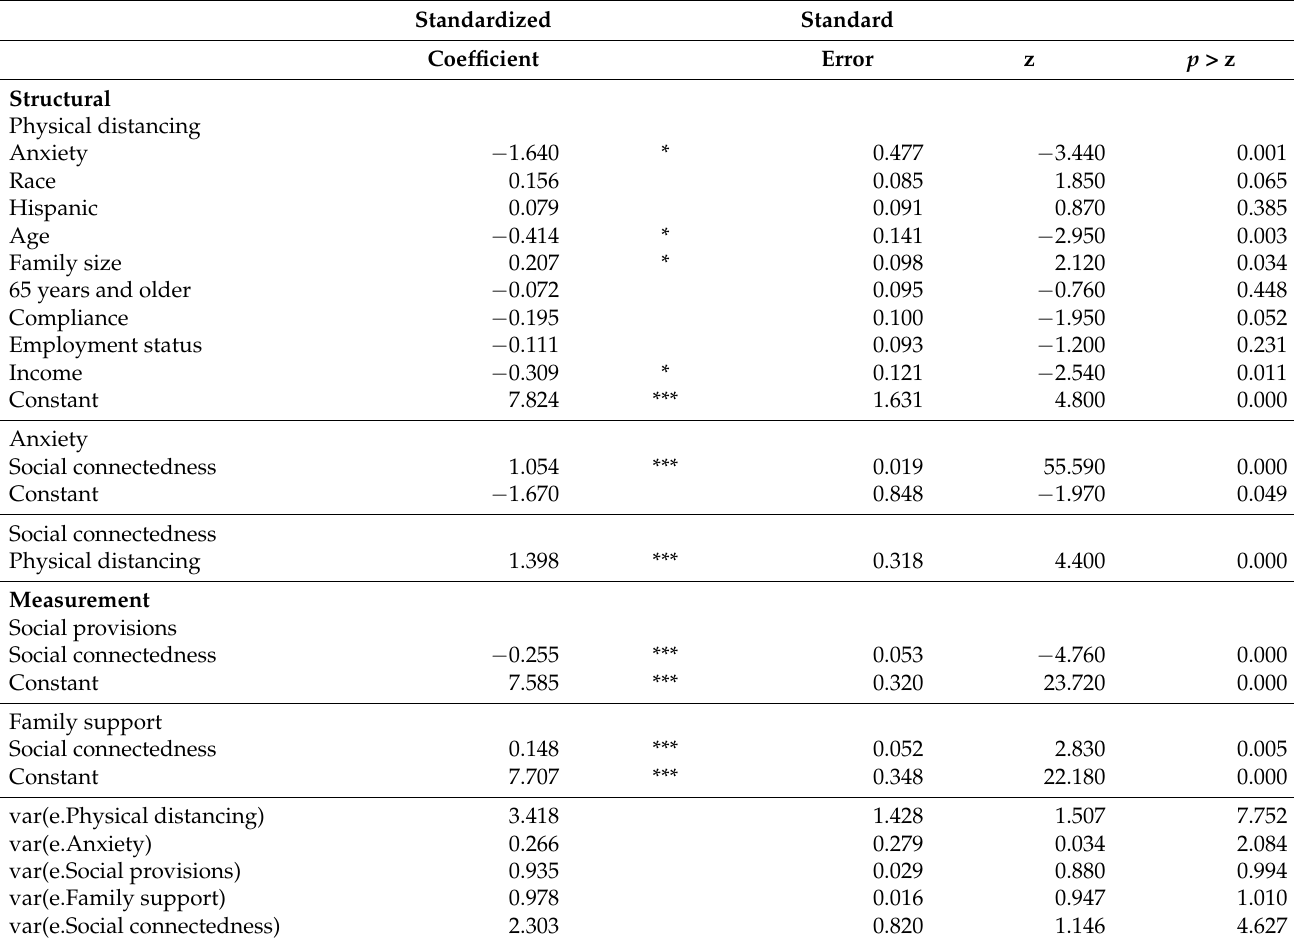
Table 1. Results of multivariate regression analysis using structural equation (SEM)